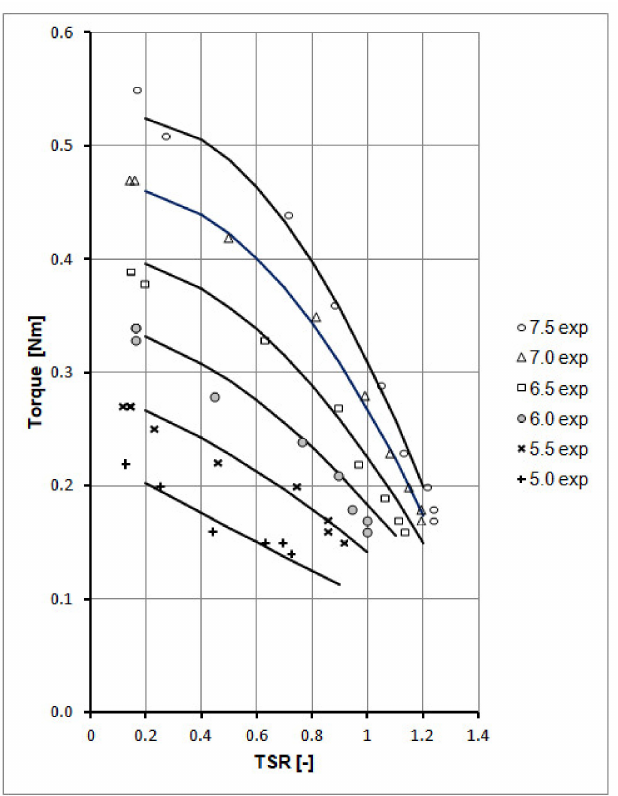
Figure 11. Comparison of measurements with approximation of characteristics (Equation (7)) for single-segment rotor.